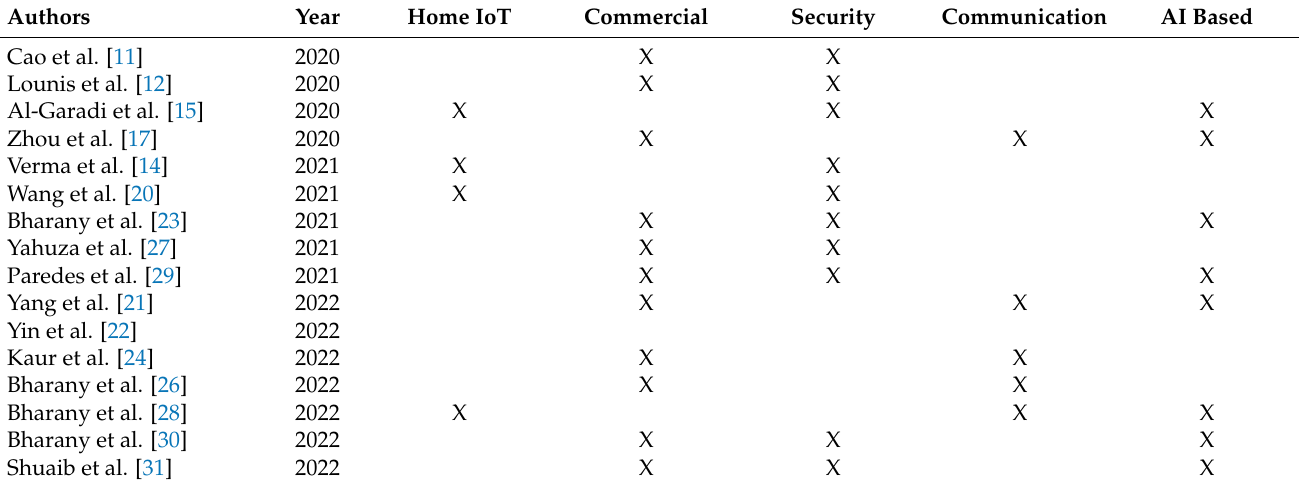
Table 2. Reviewed features of the